Question: What kind of plot is shown here?
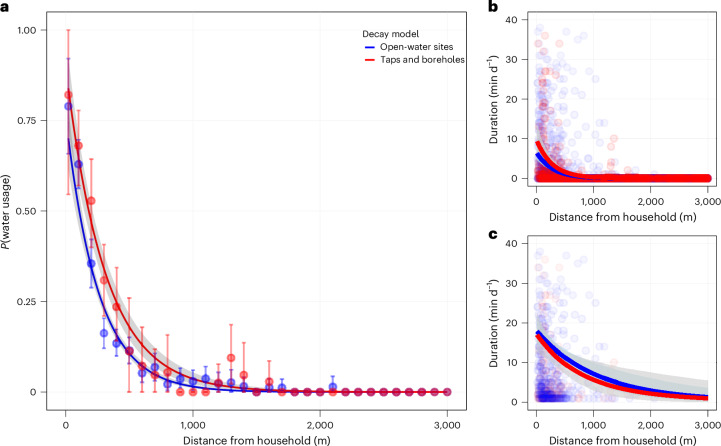
Answer: bar